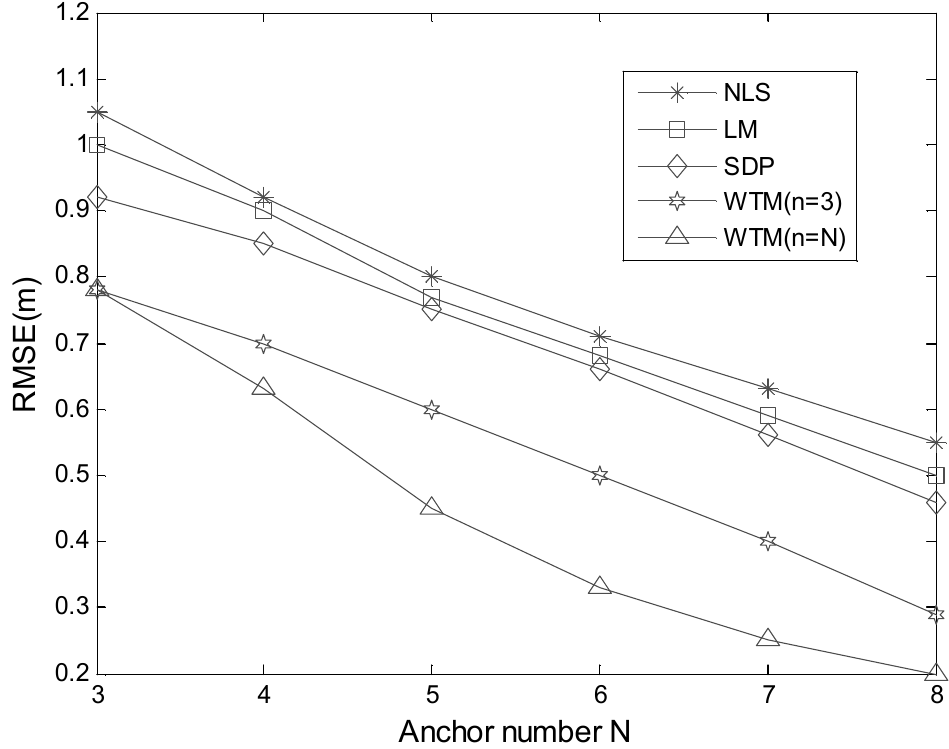
Figure 13. Localization accuracy for NLS, LM, SDP and WTM based on simulated RSSI data.